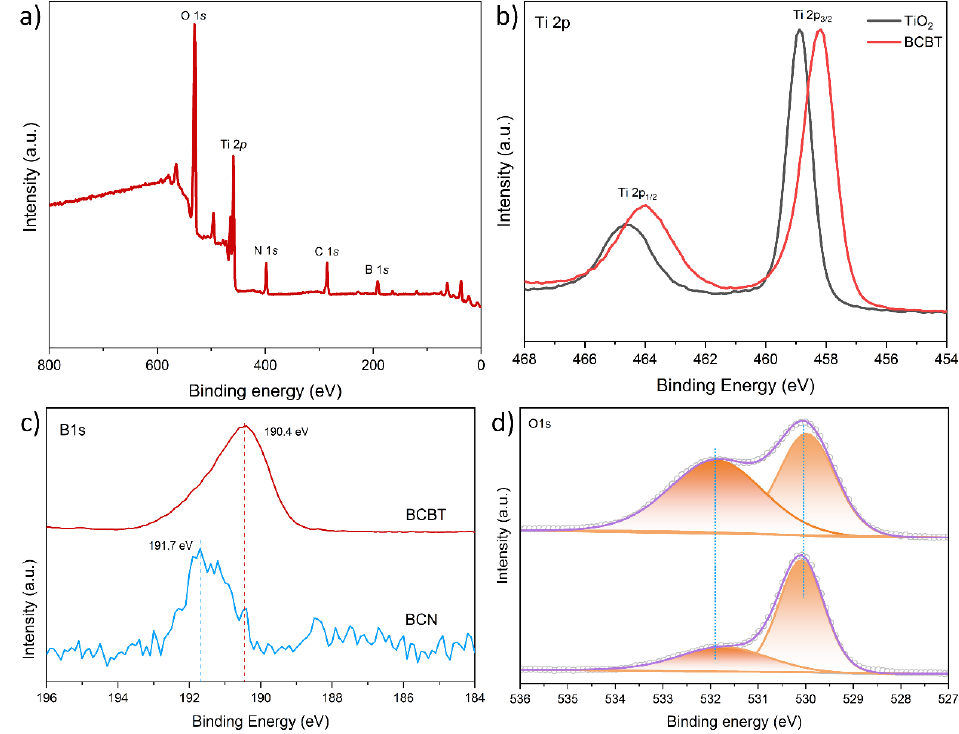
Figure 3. The XPS spectra of BT, BCB, and BCBT: ( a ) survey spectrum of BCT; ( b ) Ti 2p and ( d ) O 1 s of BT and BCBT; and ( c ) B 1 s spectra of BCN and BCBT.